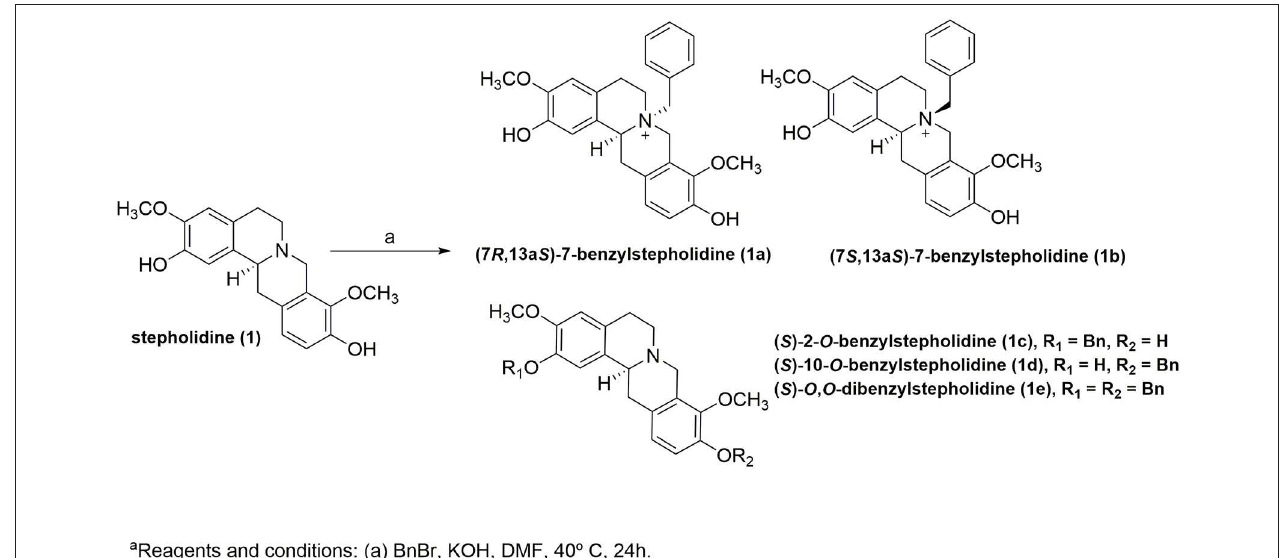
SCHEME 1 | One-step synthesis of compounds 1a − 1e a